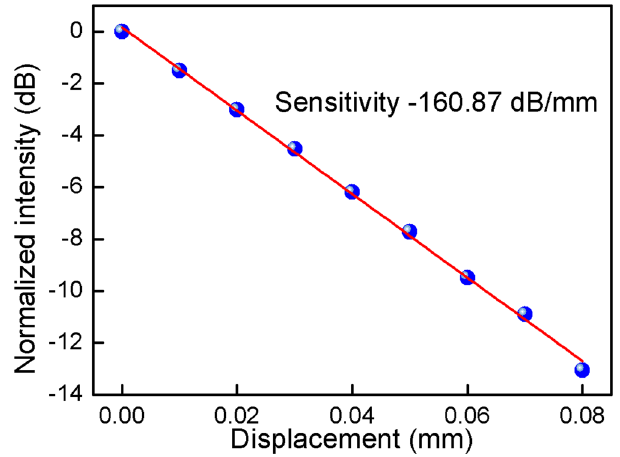
Figure 2. Linear response of the sensor output versus the applied displacement.